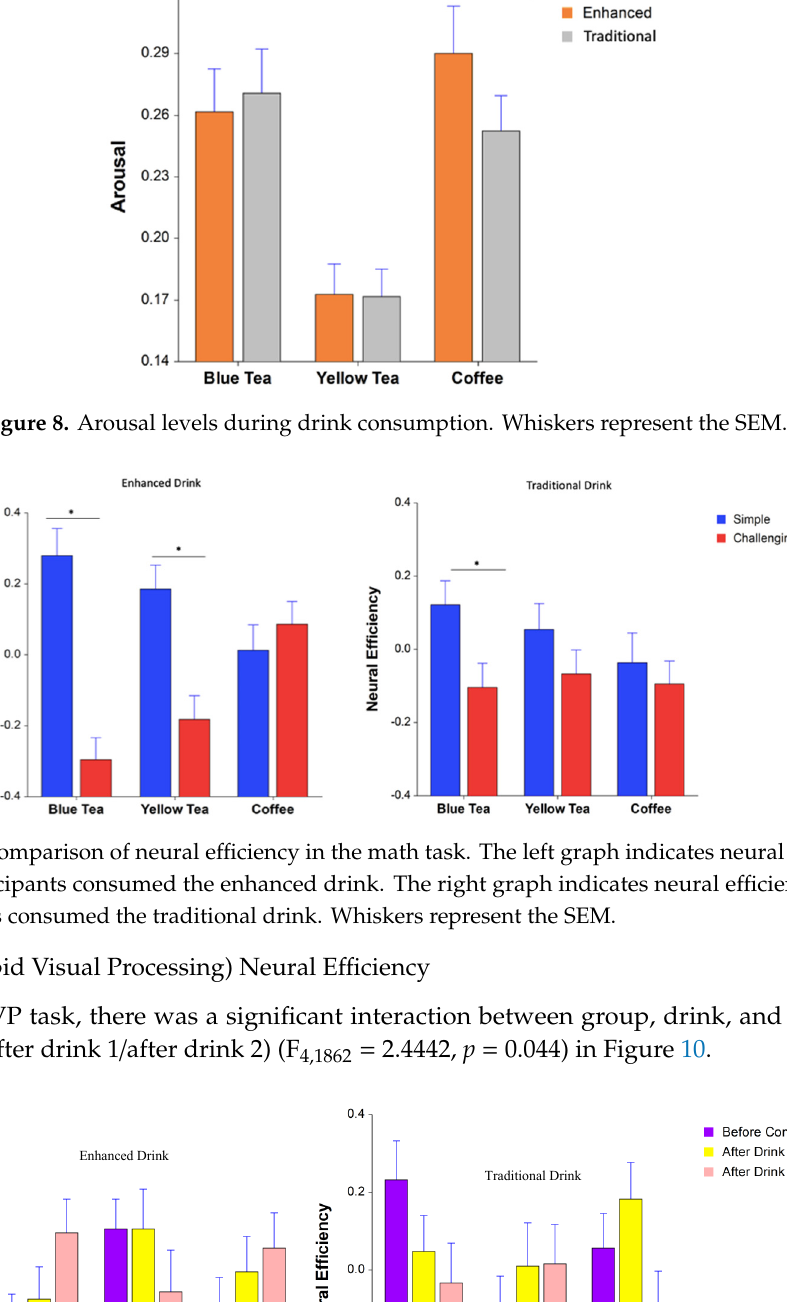
Figure 9. Comparison of neural efficiency in the math task. The left graph indicates neural efficiency while participants consumed the enhanced drink. The right graph indicates neural efficiency while participants consumed the traditional drink. Whiskers represent the SEM.